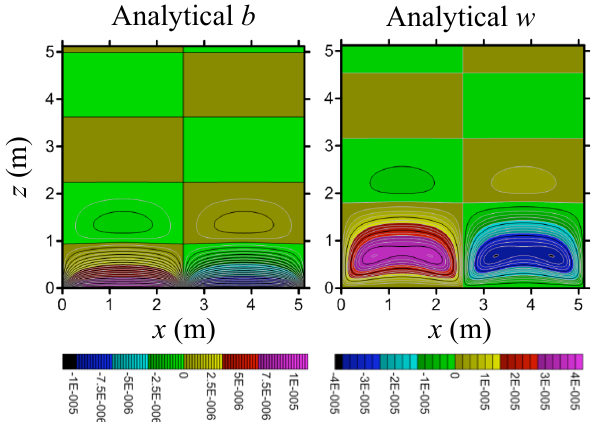
Figure 2. Vertical cross section of the analytical (A-1) buoyancy b and vertical velocity w fields from the first test case. Colour bar units are ms − 2 for b , and ms − 1 for w